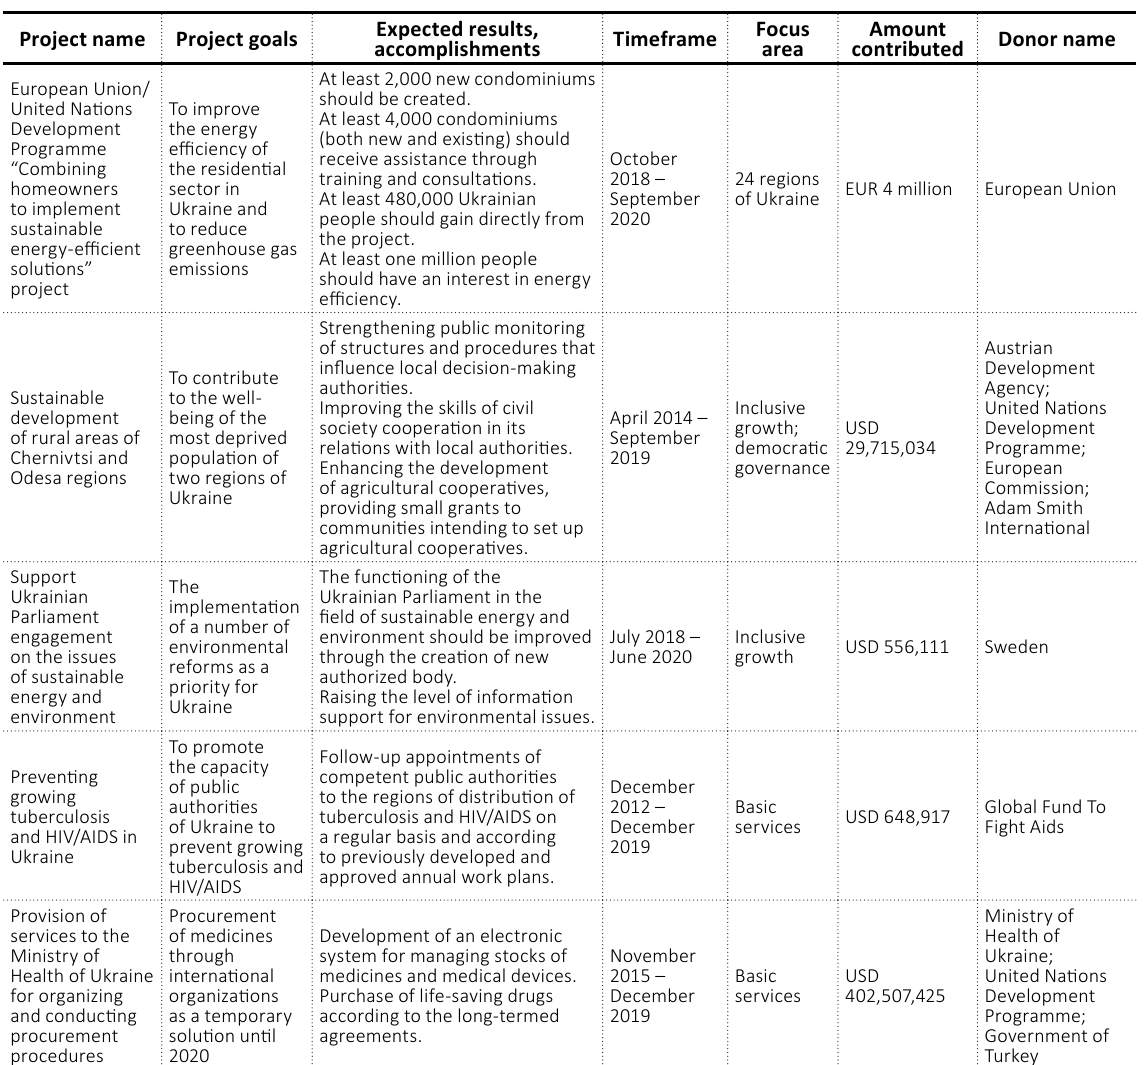
Table 1. Ongoing impact investment projects of the United Nations Development Programme in Ukraine Source: Adapted from the United Nations Development Programme